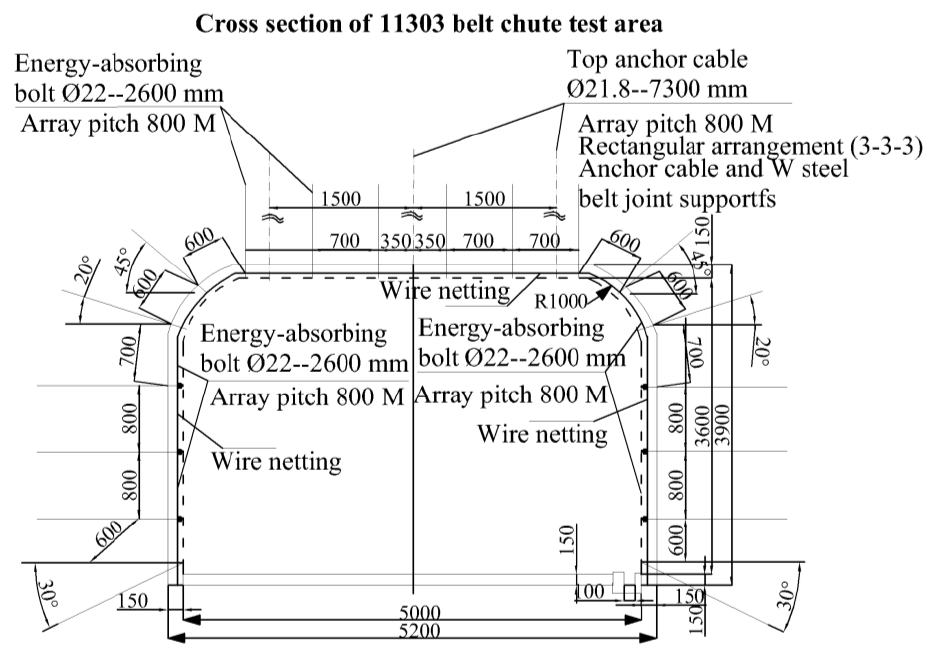
Figure 16. Section of support in the test area of 11303 tape chute.